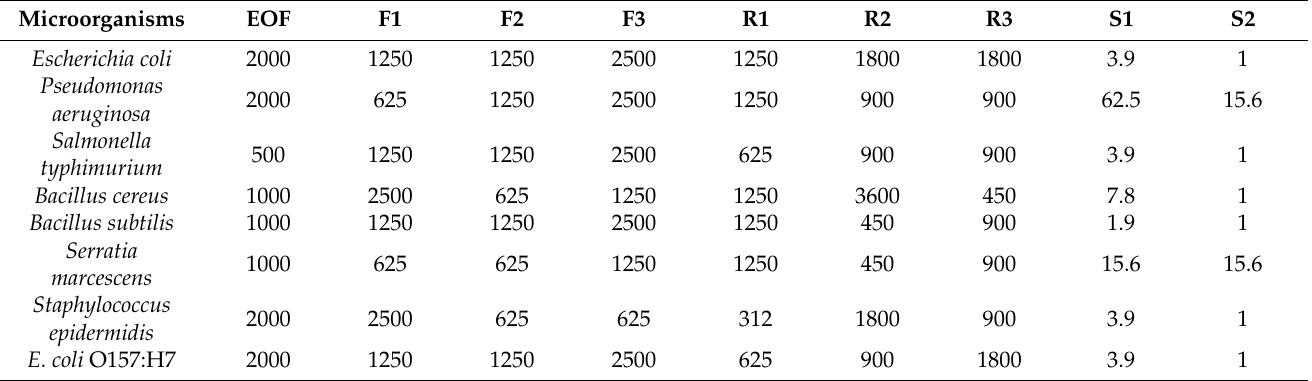
Table 2. Antibacterial activity of the fruit essential oil, fruit, and root extracts of Ferula drudeana (MIC, µ